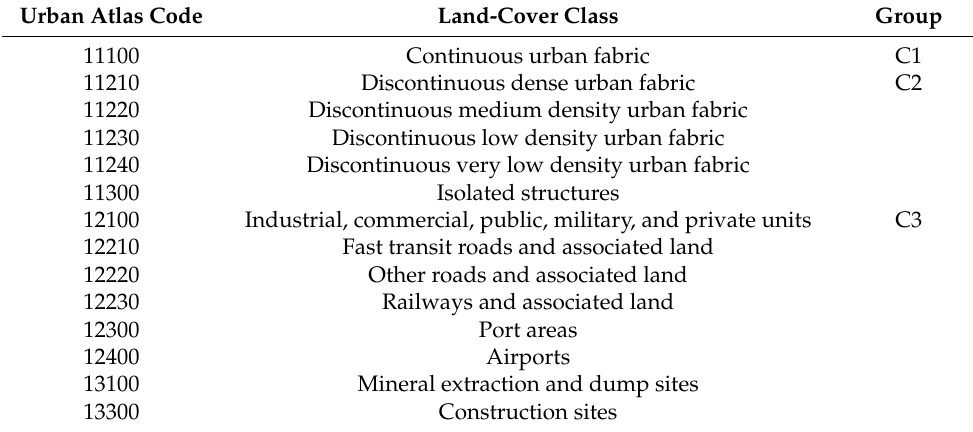
Table 2. Principles for generalising land-cover classes. Source: Petrescu